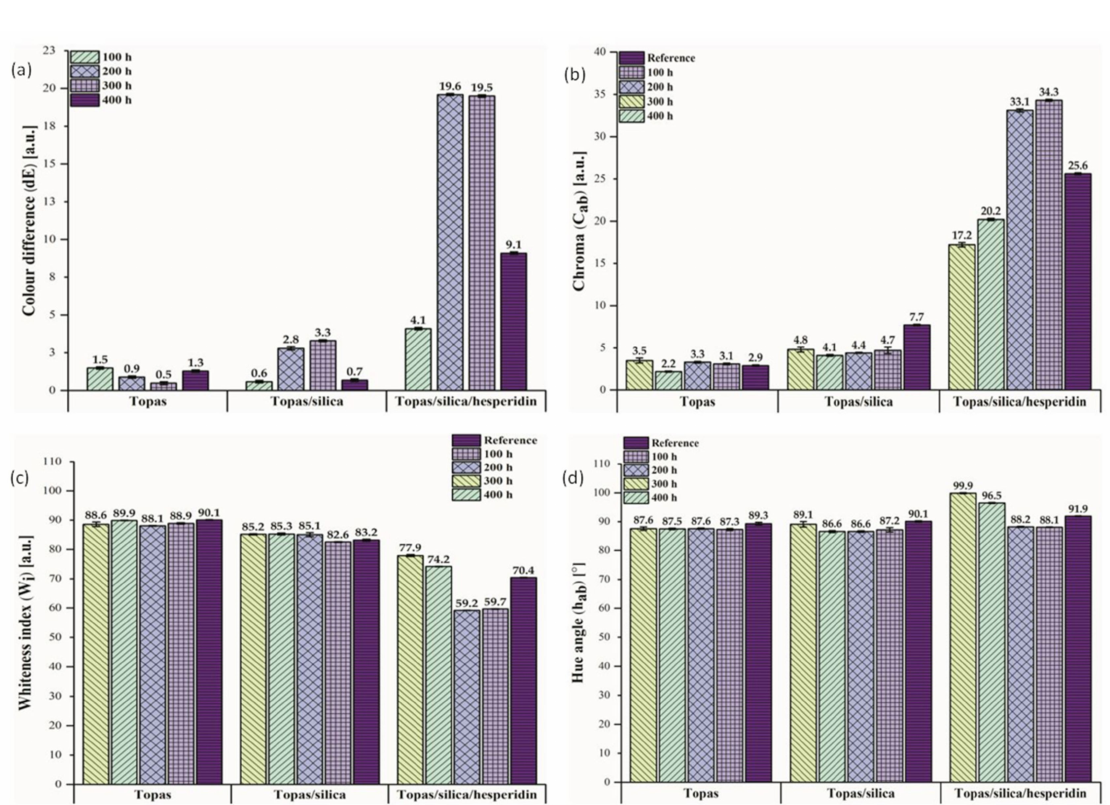
Figure 4. The influence of weathering on optical properties of Topas blends: ( a ) colour difference (dE), ( b ) chroma (C ab ), ( c ) whiteness index (W i ), ( d ) hue angle (h ab